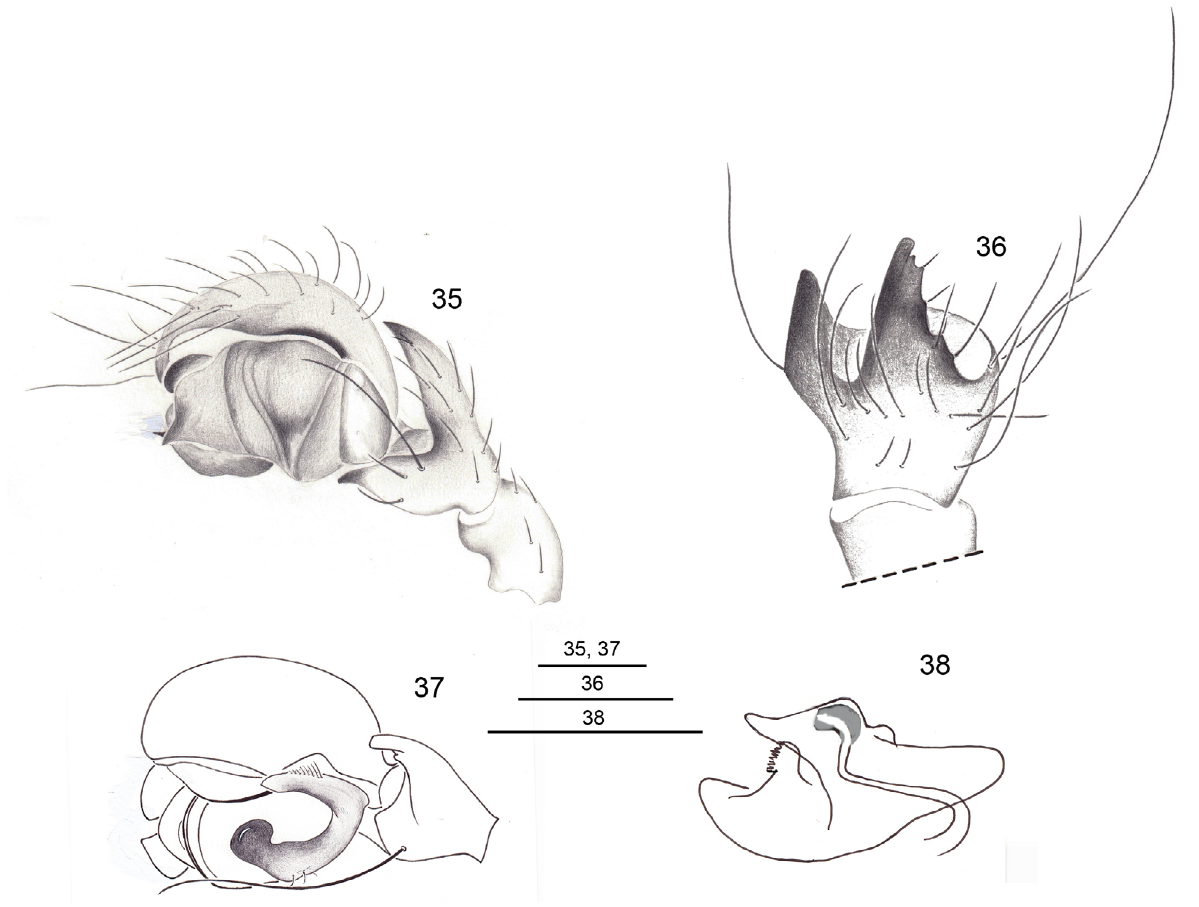
Figs 35-38. Holmelgonia disconveniens sp. nov. (♂ holotype). 35 . Palp, retrolateral view. 36 . Palpal tibia, dorsal view. 37 . Palpal tibia, dorsolateral view. 38 . Embolic division of palp, ventrolateral view. Scale bars = 0.1